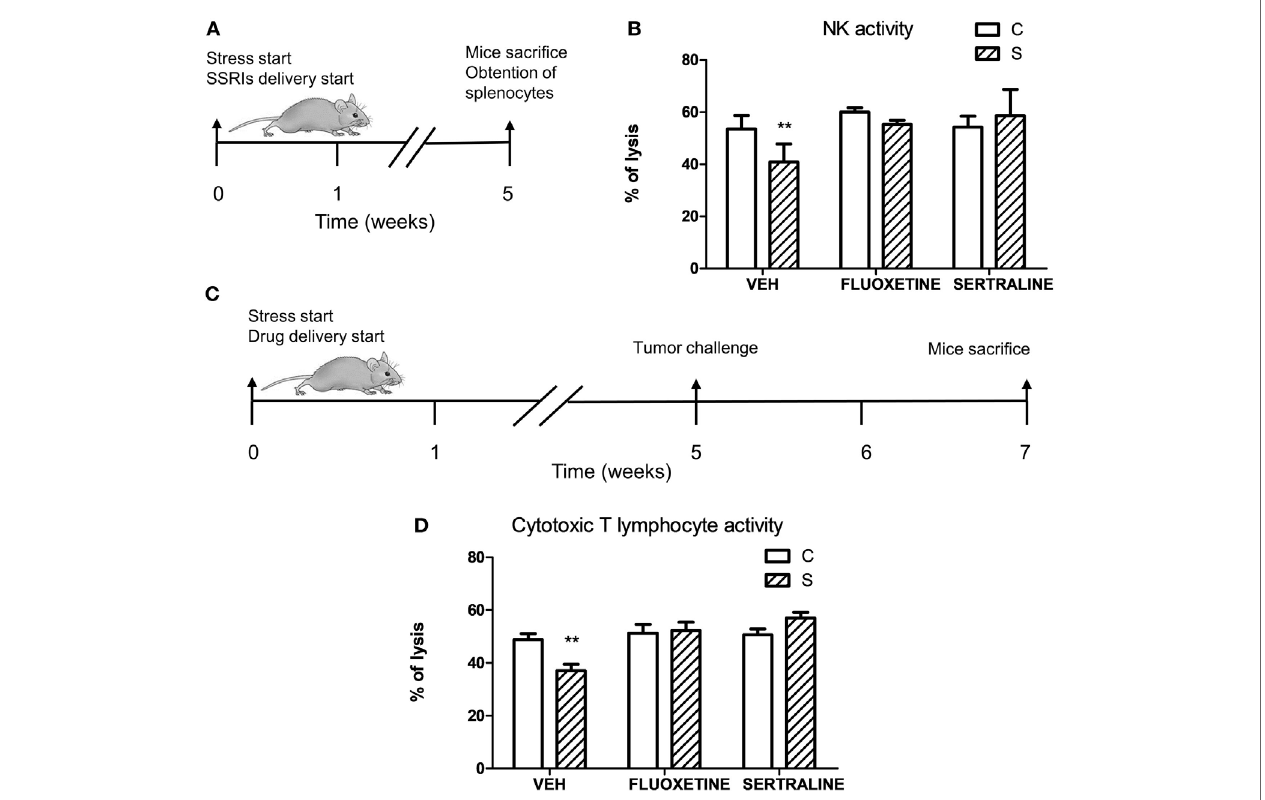
FigUre 8 | Influence of chronic stress and antidepressant treatment on antitumor immunity. (a) Schematic representation of experimental protocol. Mice were treated either with (S) or without (C) the chronic stress protocol, and with or without (VEH) fluoxetine or sertraline. Five weeks later, mice were sacrificed. (B) Splenocytes of mice from different experimental groups were co-incubated with YAC-1 cells labeled with [3 H]-thymidine at a target:effector ratio 1:50, cultured for 3.5 h and harvested. n = 4 mice per group. (c) Schematic representation of experimental protocol. C57BL/6J mice were treated either with (S) or without (C) the chronic stress protocol, and with or without (VEH) fluoxetine or sertraline. Five weeks later, 3 × 10 6 EL4 cells were subcutaneously injected to generate solid tumors. Two weeks post injection (p.i.), mice were sacrificed and spleen cell suspensions were obtained. (D) Specific cytotoxic activity against tumor cells was evaluated co-culturing spleen cells suspensions from tumor-bearing mice and labeled EL4 cells with [3H]-thymidine at a target:effector ratio 1:15 for 3.5 h and harvesting. Percentages of NK or cytotoxic activity were calculated as 100 × (SR − ER)/SR, where SR is the spontaneous release and ER is the experimental release. n = 7 mice per group. Values are expressed as mean ± SEM. ** p < 0.01 respect to control